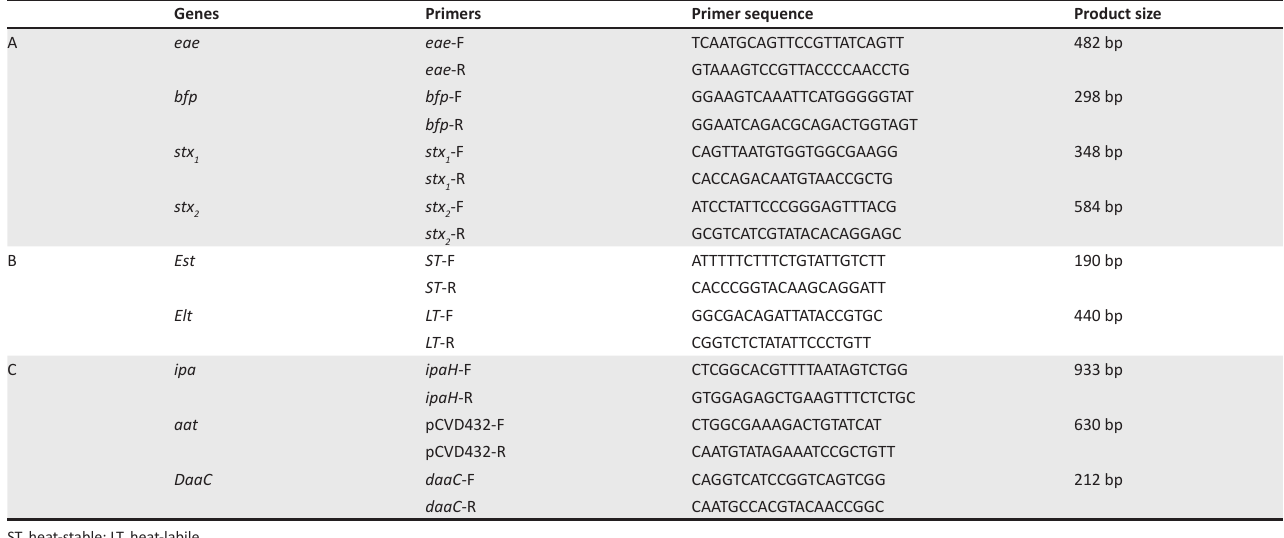
TABLE 2: Primers used for detection of virulence genes by conventional polymerase chain reaction.